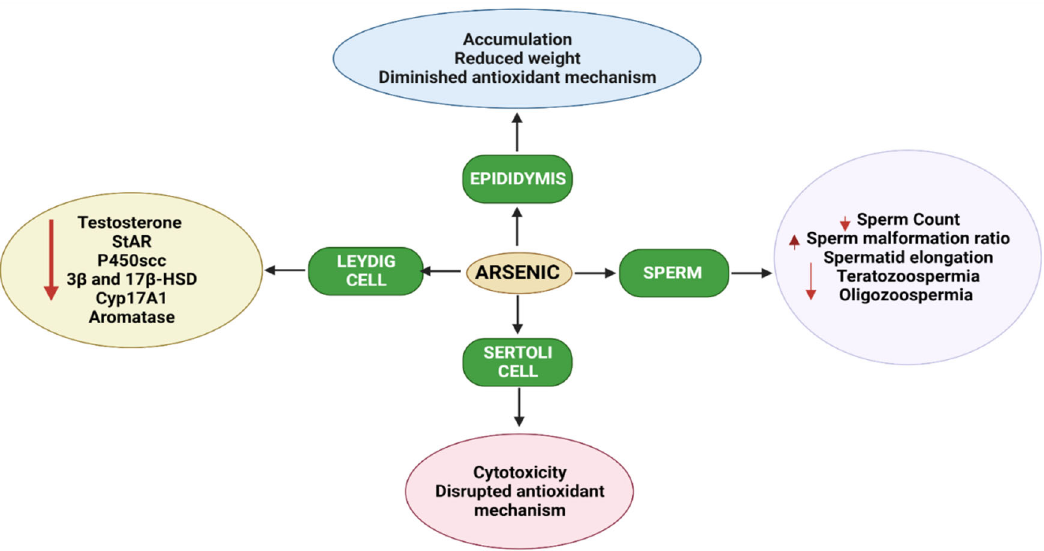
Figure 5. Diagram demonstrating how exposure to arsenic has a negative impact on Leydig’s and Sertoli cells, sperm, and epidydimis, and eventually damages the testis at the cellular and gene levels. StAR, steroidogenic acute regulatory protein; CYP17A1, Cytochrome P450 17A1; 17 β HSD, 17 ‐ beta ( β ) ‐ hydroxysteroid dehydrogenase.